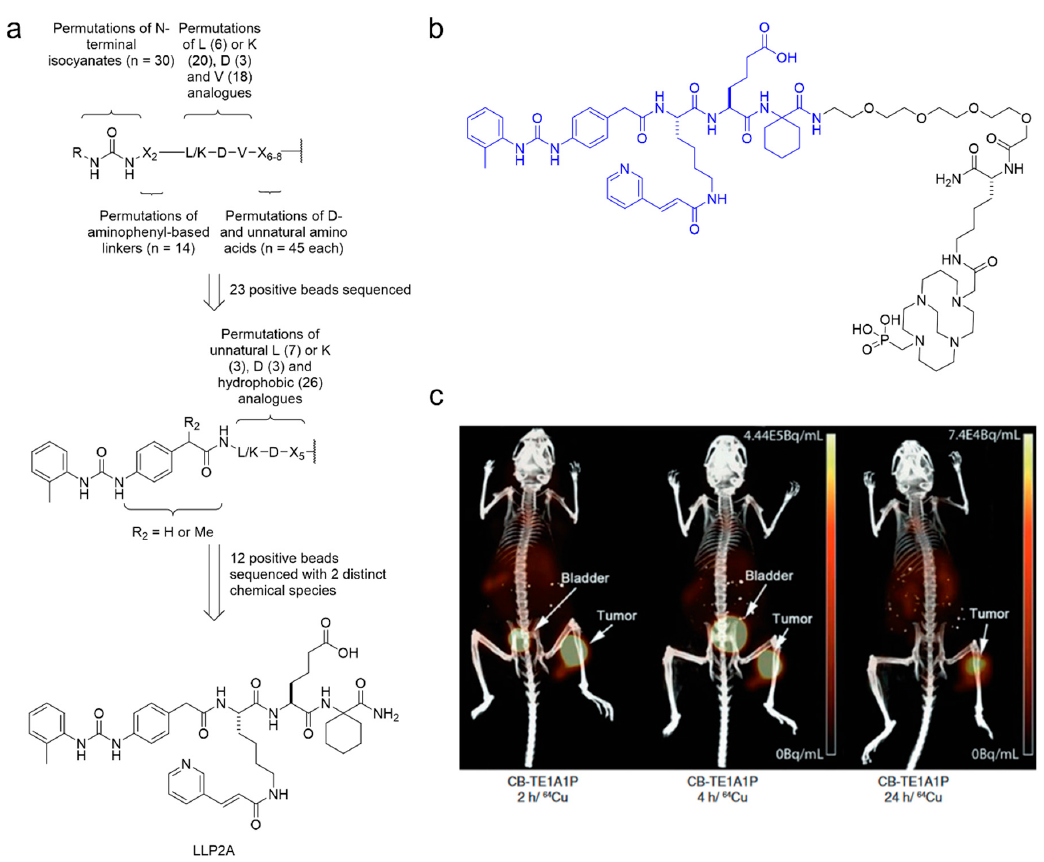
Figure 8. Integrin α 4 β 1 targeting by LLP2A . ( a ) The design of the diverse and focused library targeting integrin α 4 β 1, leading to the identification of the LLP2A pharmacophore. ( b ) Chemical structure of LLP2A-CB-TE1A1P, a precursor for 64 Cu-labeling currently being evaluated in Phase I